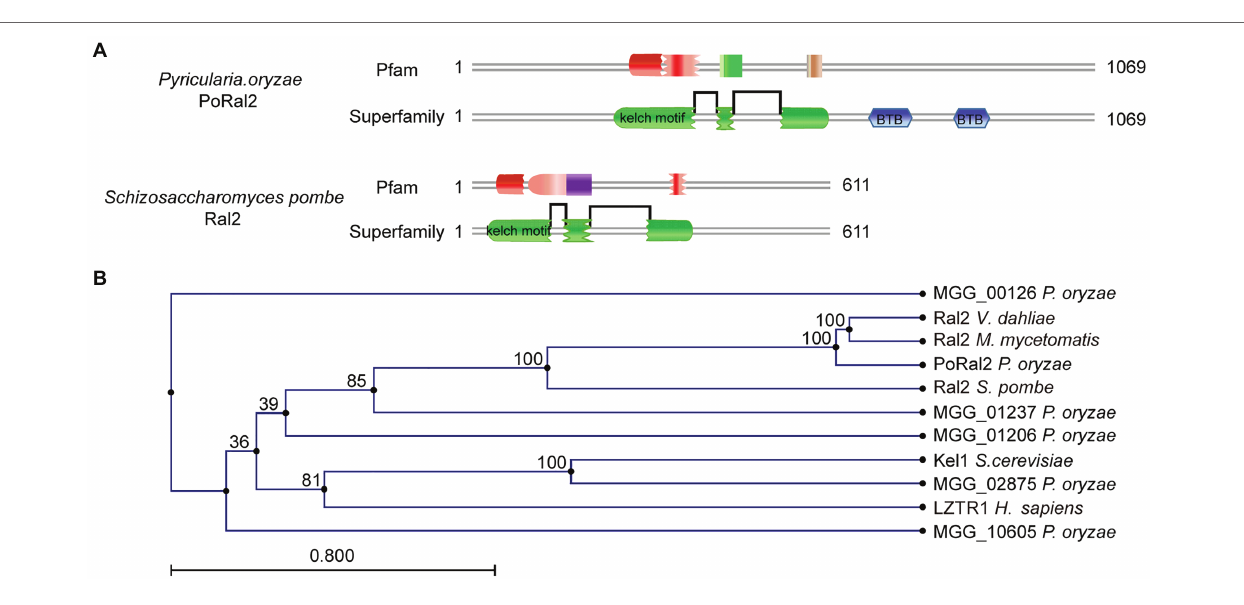
FIGURE 1 | Identification of PoRal2 in Pyricularia oryzae . (A) Protein sequence analysis via the profile-HMM database showed that both P. oryzae PoRal2 and Schizosaccharomyces pombe Ral2 proteins contain three kelch repeats. (B) Alignment tree of PoRal2 and Ral2 proteins from S. pombe , Verticillium dahlia (XP_009657748), Madurella mycetomatis (KXX79671), Saccharomyces cerevisiae (Kel1), human (LZTR1), and six kelch domain containing proteins (PoRal2, MGG_00126, MGG_01206, MGG_01237, MGG_02875, and MGG_10605) in P. oryzae were constructed using the CLC Main